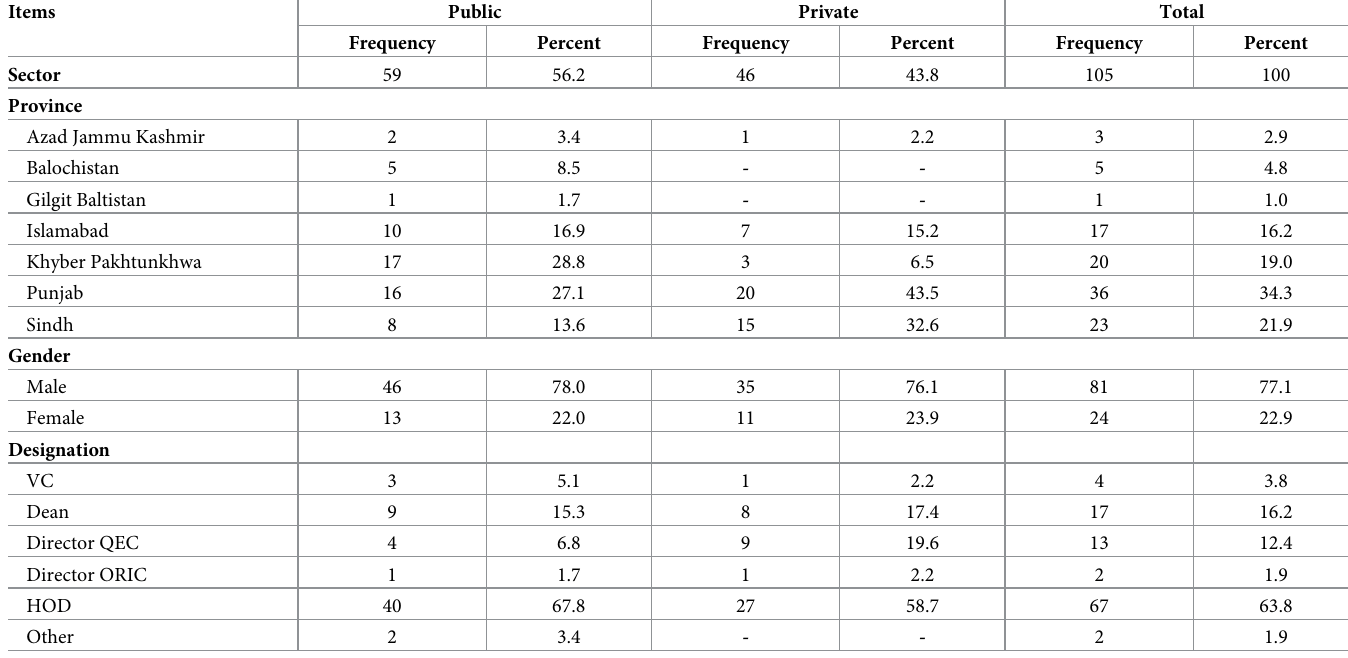
Table 1. Demographic characteristics of